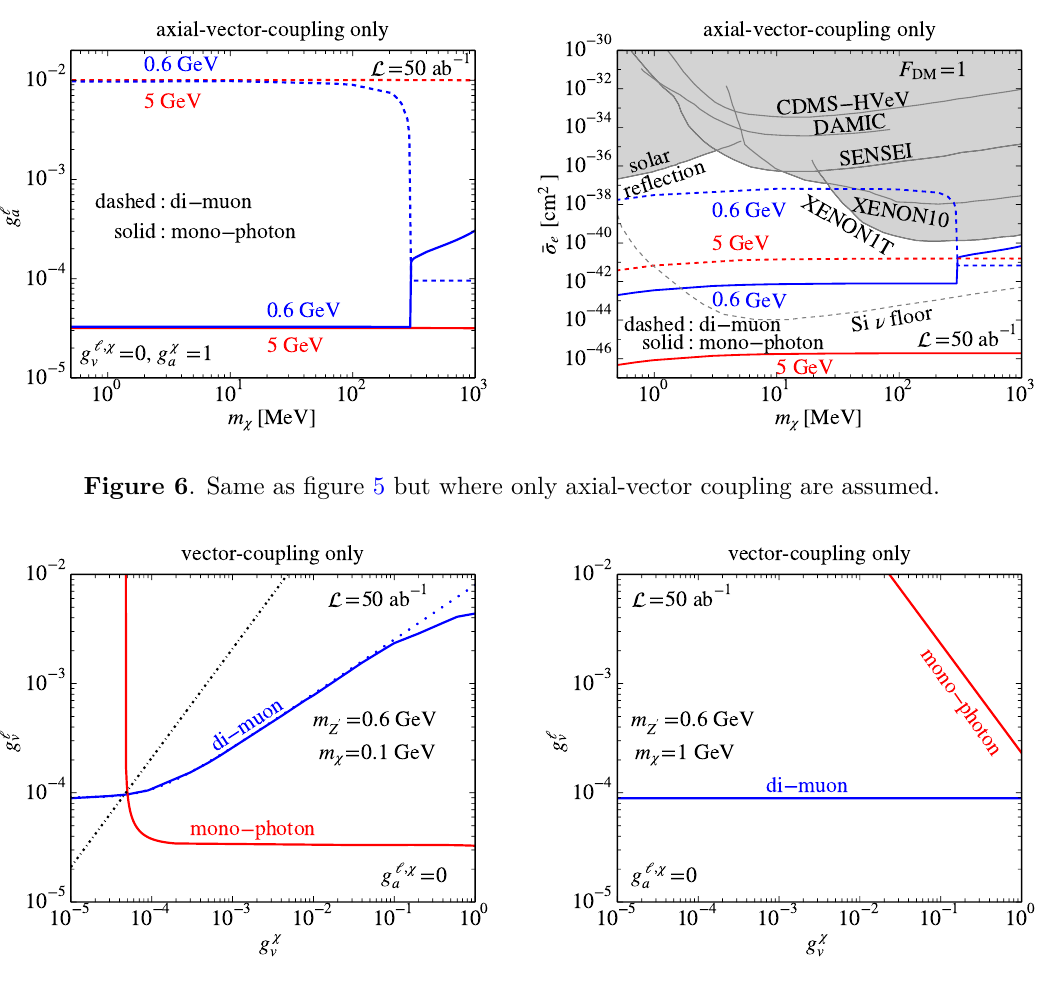
Figure 7 . Left panel: expected Belle II 90% C.L. upper bound on g ‘ the di-muon channel (blue) and from the mono-photon channel (red) with 50 ab − 1 integrated luminosity, m = 0 . 6 GeV , m = 0 . 1 GeV, and only vector couplings. The parameter space, where Z 0 χ the sensitivity of the visible channel is the same as the invisible channel, is approximated by the black dot-dashed line, which is g ‘ = 2 g χ . The upper bound in the di-muon channel estimated by v v neglecting the γ − Z 0 interference term is indicated by the blue dotted line. Right panel: same as the left panel but with m = 1 χ